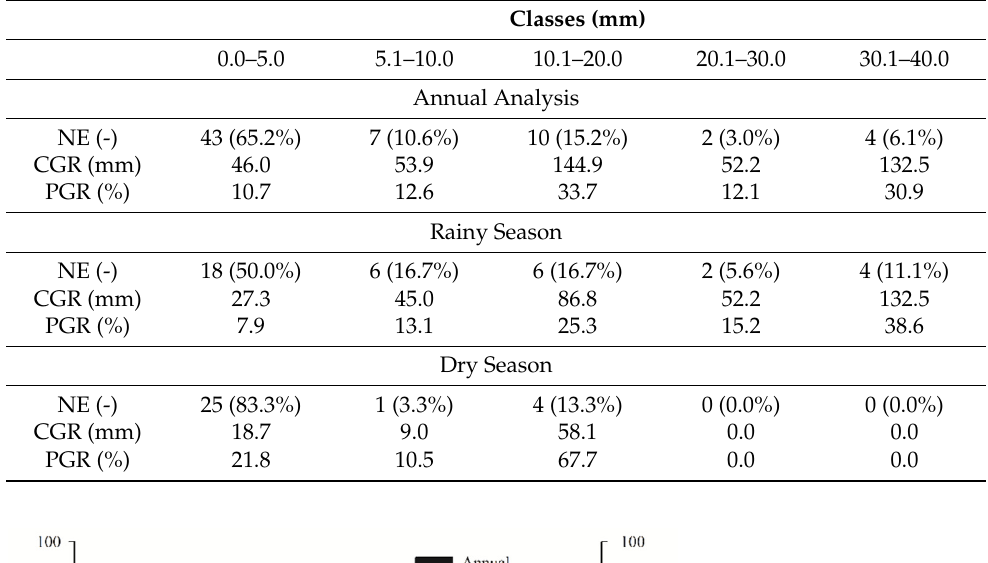
Table 3. Number of events (NE), cumulative gross rainfall (CGR) and percentage of gross rainfall (PGR) in different rainfall classes during the study period.